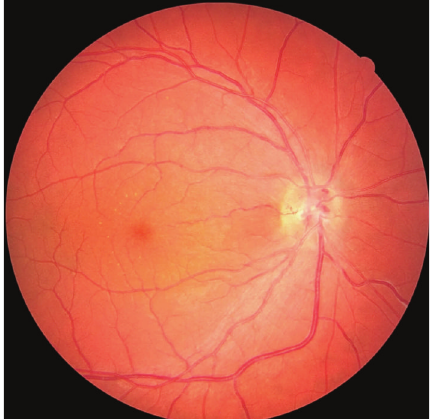
Figure 4: Fundus retinography (Canon CX-1, Canada) of the right eye, after ranibizumab treatment, showed resolution of retinal and optic disc edema, venous dilation, and